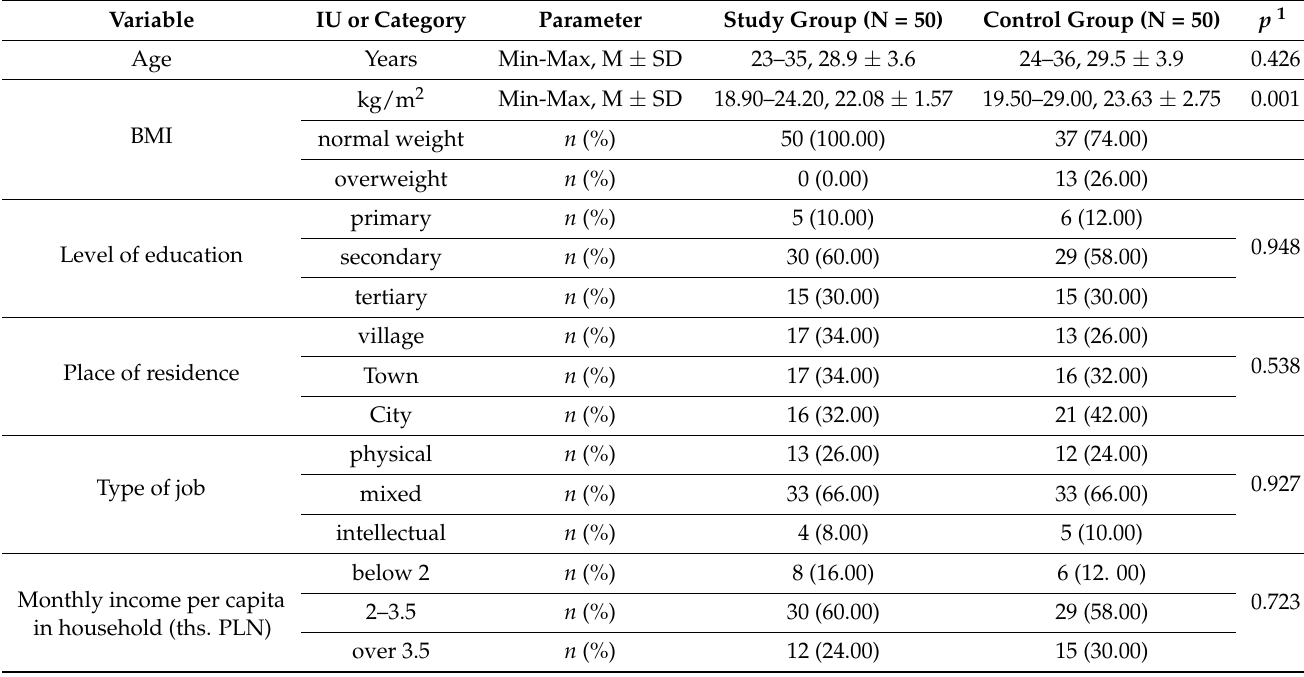
Table 1. Characteristics of the study group and the control